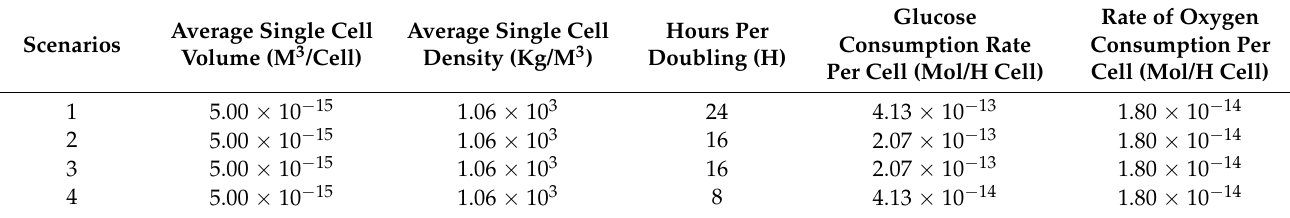
Table A2. Model variable inputs: Cell